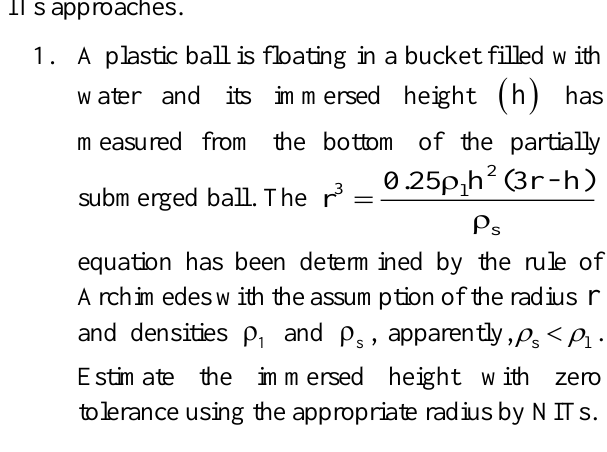
Solution of (i) by NITs and comparison of the models. Nonlinear